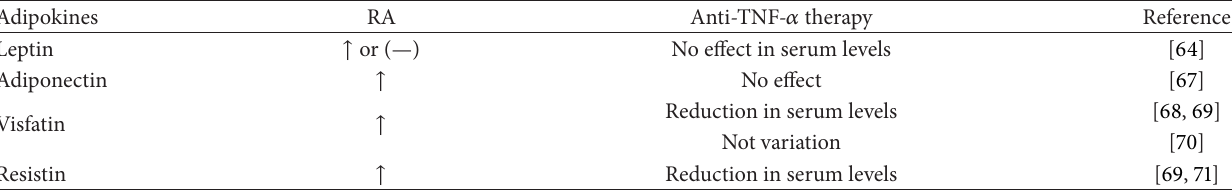
Table 1: Major adipokines and the effect of anti-TNF- 𝛼